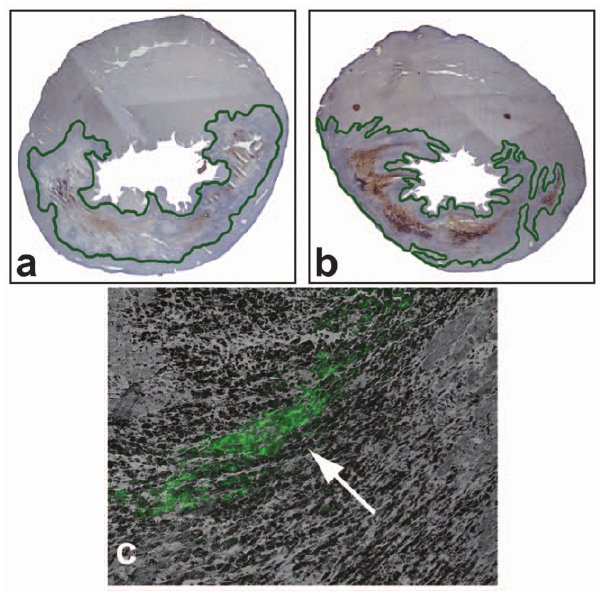
Figure 2. Immunostaining for Ab-HepIII in the infarct region. Hearts from rats sacrificed on 1 day after injection. The rats were injected intravenously with either ( a ) PBS or ( b ) the Ab-HepIII 1 day post-MI. The presence of the Ab is indicated by the brown stain. For the sake of clarity, we have outlined the infarct region. At high magnification, we were also able to see fluorescence within the infarct region( c ), as indicated by the arrow, of the FITC-labeled peptides (indicated in black).